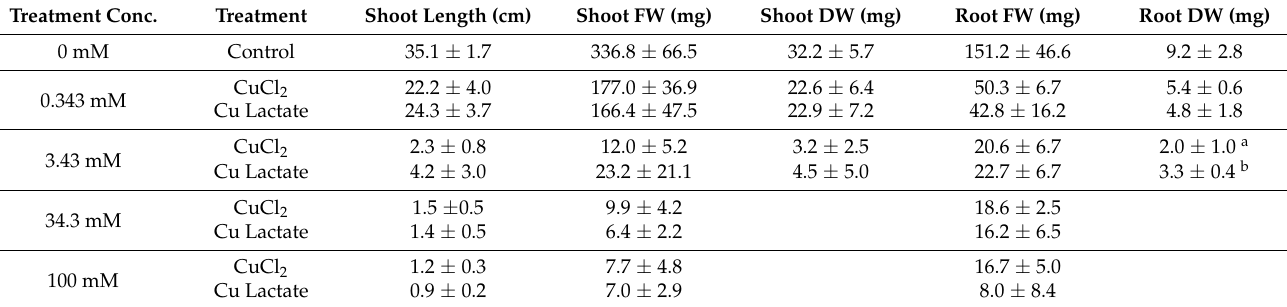
Table 5. Plant growth parameter results for copper (Cu) treatments. After 13 days of growth, wheat seedlings were harvested, and shoot length was measured along with fresh weight (FW) and dry weight (DW) of both root and shoot tissue. A t -test was used to identify differences between copper chloride and copper lactate within each treatment level for each plant growth parameter, where superscripts “a” and “b” denote treatment differences of p < 0.05. ± : standard deviation. Treatment Conc.